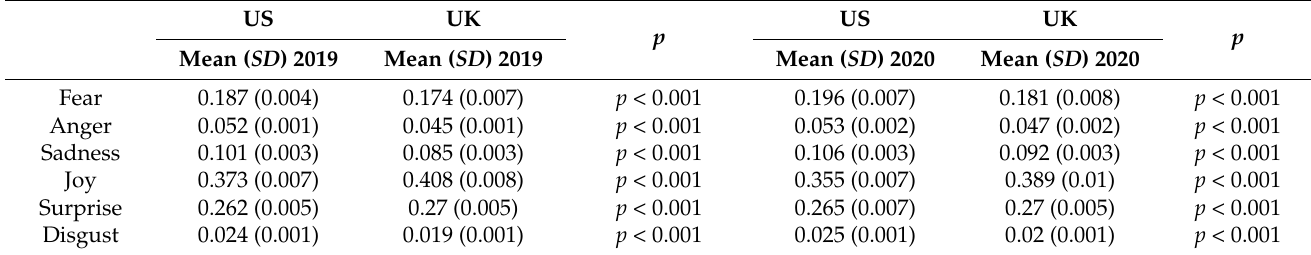
Table A2. Mean values emotions for US and UK HCPs pre- and